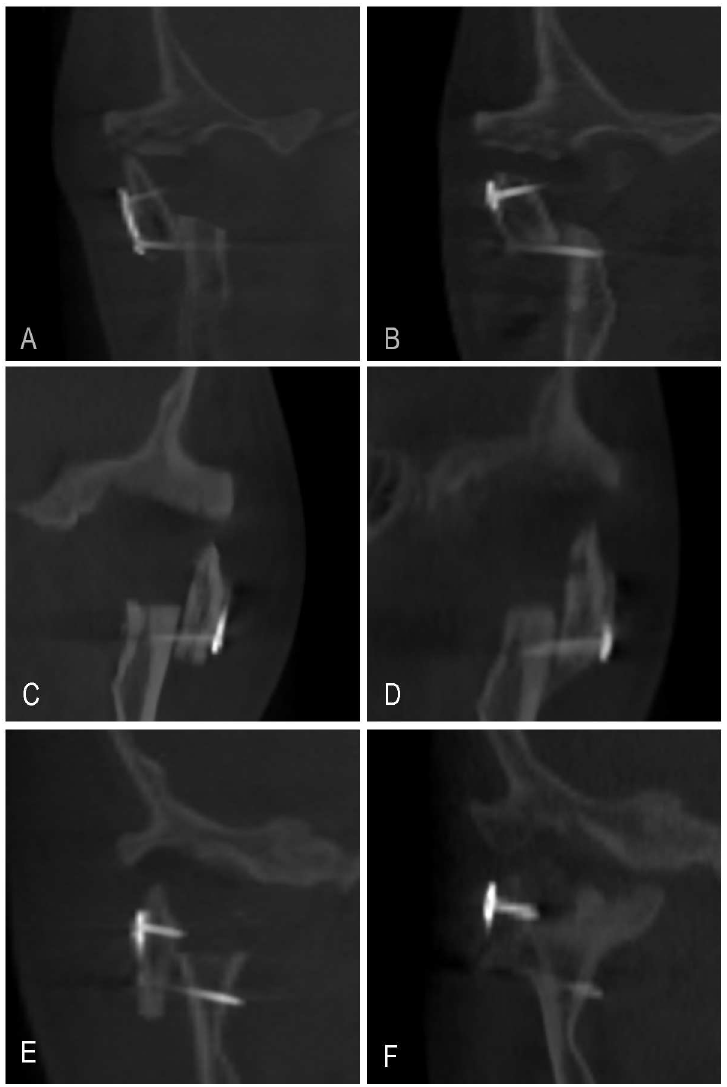
boundarywith the new bone tissue was visible(C: T1 point; D: T2 point). coronoidprocess graft bone hyperplasia with bony fusion (E: T1 point; F: T2